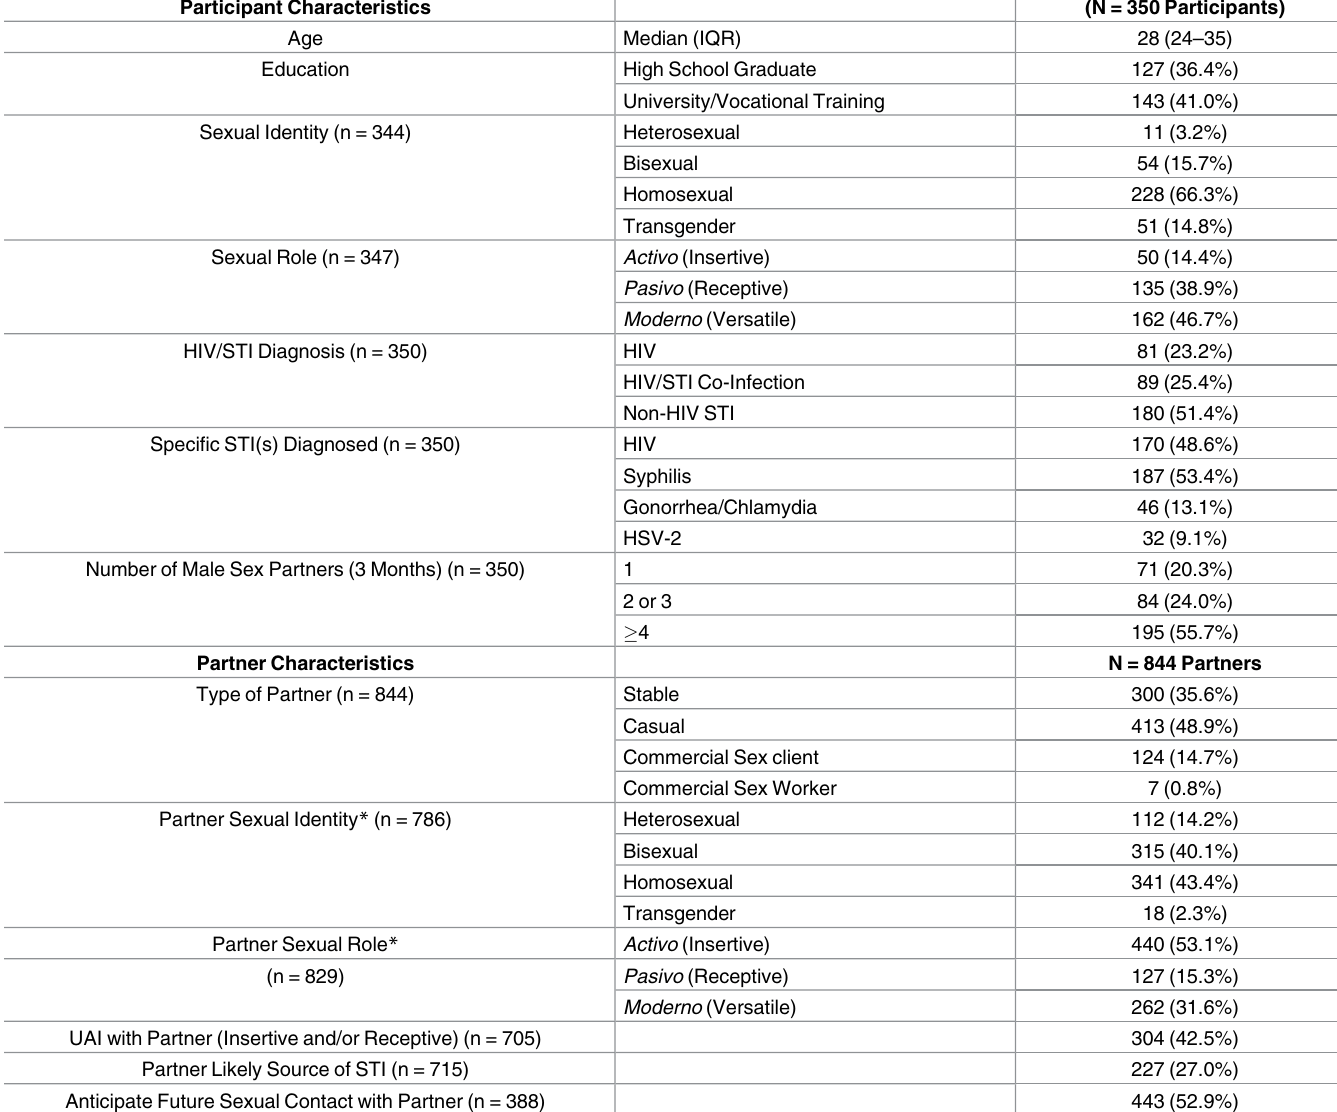
Table 1. Participant and Partner Characteristics of MSM/TW Recently Diagnosed with HIV and/or STI; Lima, Peru 2011. Participant